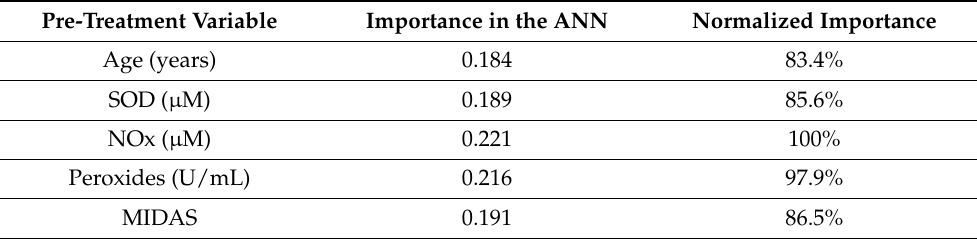
Table 2. Results of ARIANNA with the weights associated with each pre-treatment variable for determining the MIDAS post-treatment as the